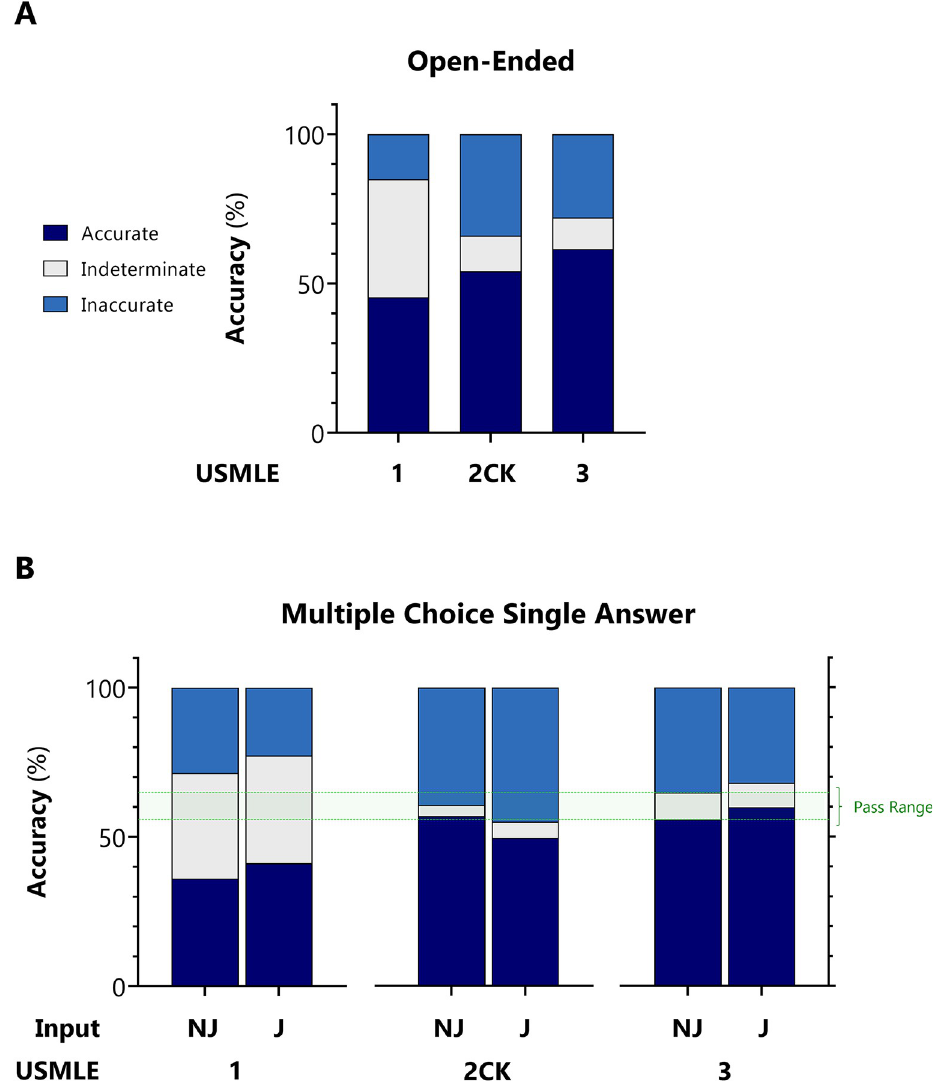
Fig 2. Accuracy of ChatGPT on USMLE. For USMLE Steps 1, 2CK, and 3, AI outputs were adjudicated to be accurate, inaccurate, or indeterminate based on the ACI scoring system provided in S2 Data . A: Accuracy distribution for inputs encoded as open-ended questions. B: Accuracy distribution for inputs encoded as multiple choice single answer without (MC-NJ) or with forced justification (MC-J).